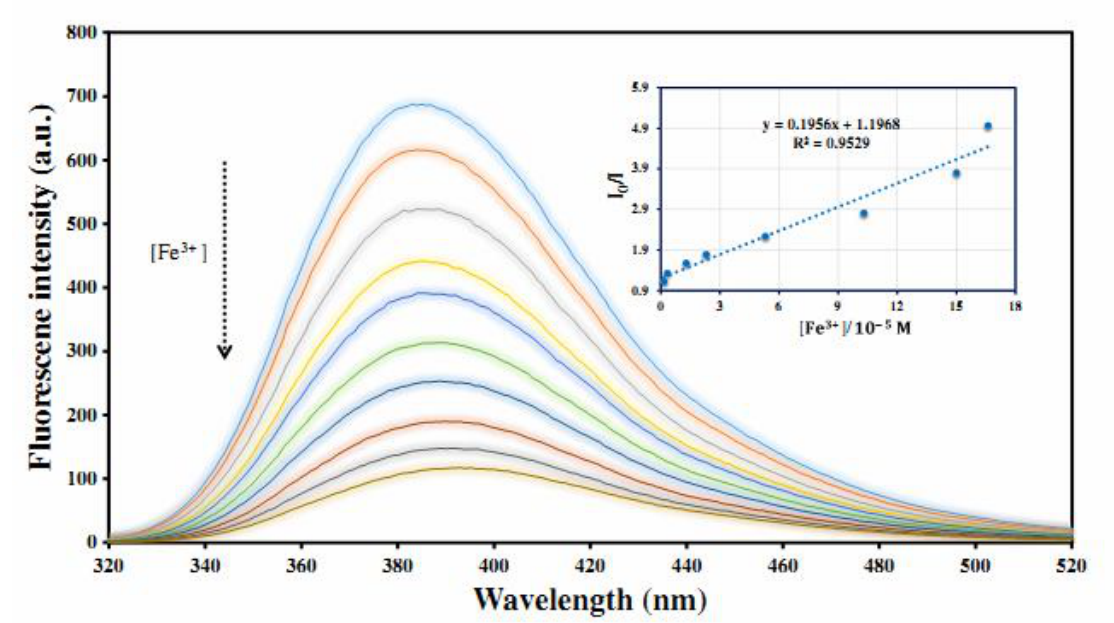
Fig. 21. The fluorescence response of the suspended SBA-15-NCO with different concentrations of Fe 3+ . The inset is the Stern-Volmer plot